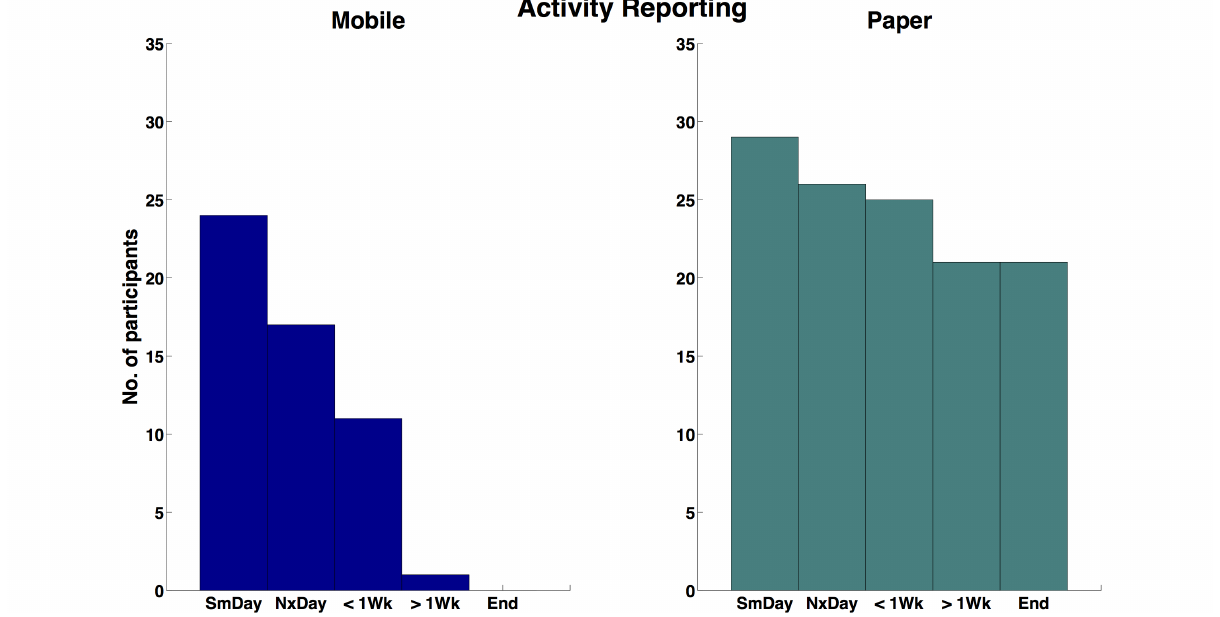
Figure 4. Histograms showing time frequency of participants’activity compliance self-report in the Mobile and ePaper conditions; frequency distributions were significantly different (Kolmogorov-Smirnov test, P<.001) between Mobile and ePaper conditions. KEY: Sm Day: Same Day as scheduled activity; Nx Day: Next Day after scheduled activity.